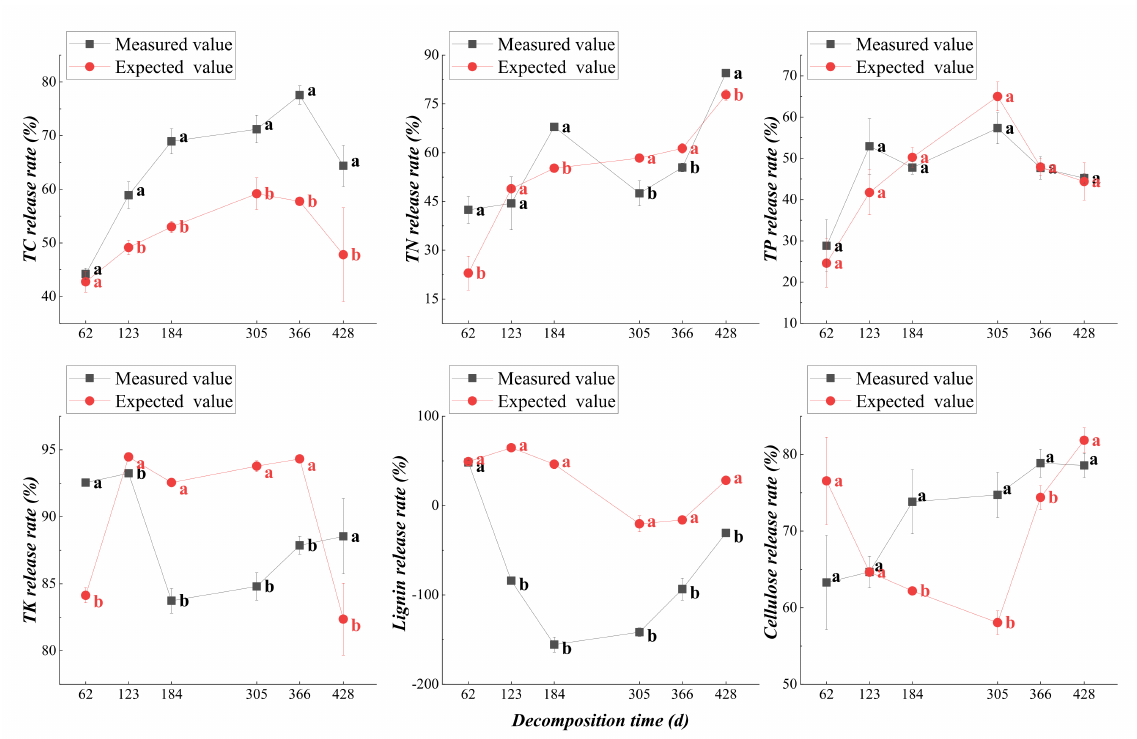
Figure 13. Measured and expected values of the nutrient release rate during CBL plant residue decomposition. Note: a, b—differences between expected value and measured value in the same decomposition period ( p <